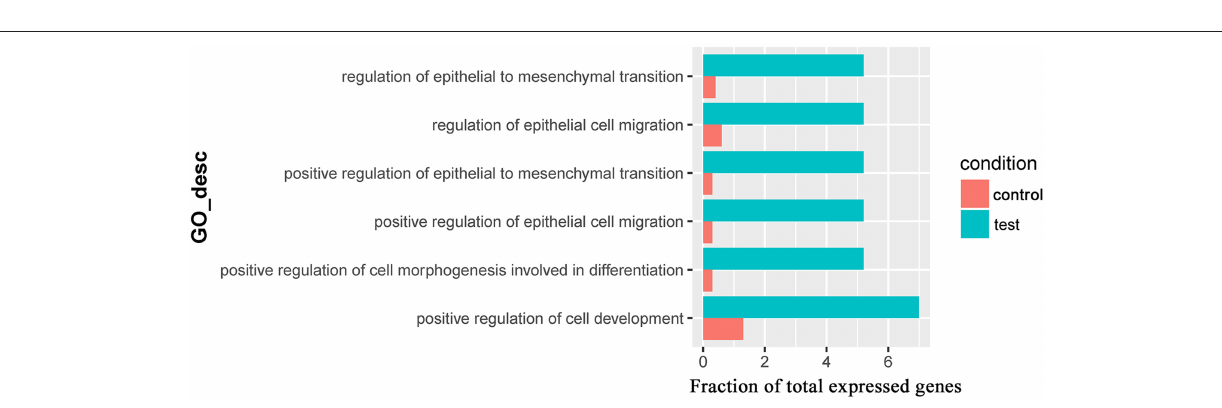
FIGURE 6 | The overrepresented GO terms of the significantly downregulated genes in the Control_18h/Heat_18h comparison of coral Galaxea fascicularis